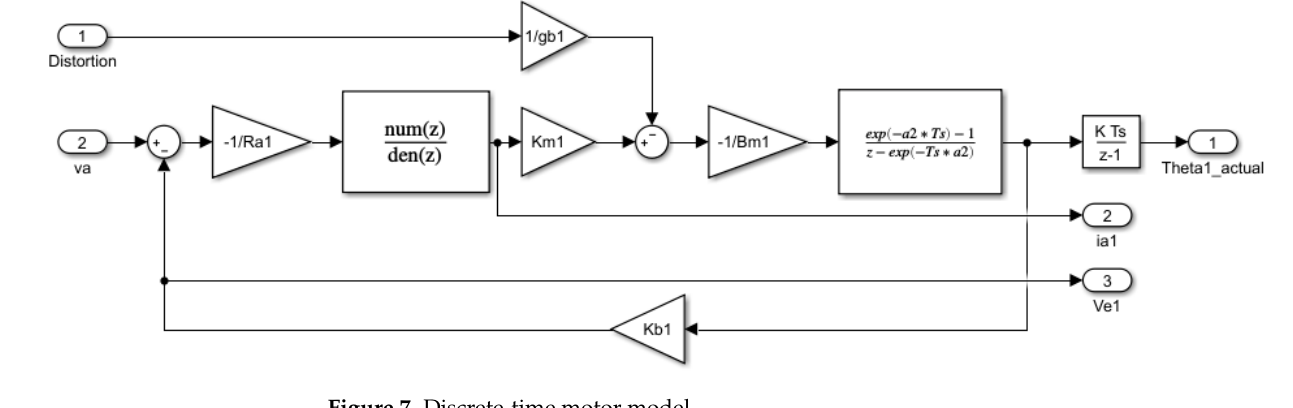
Figure 7. Discrete-time motor model.